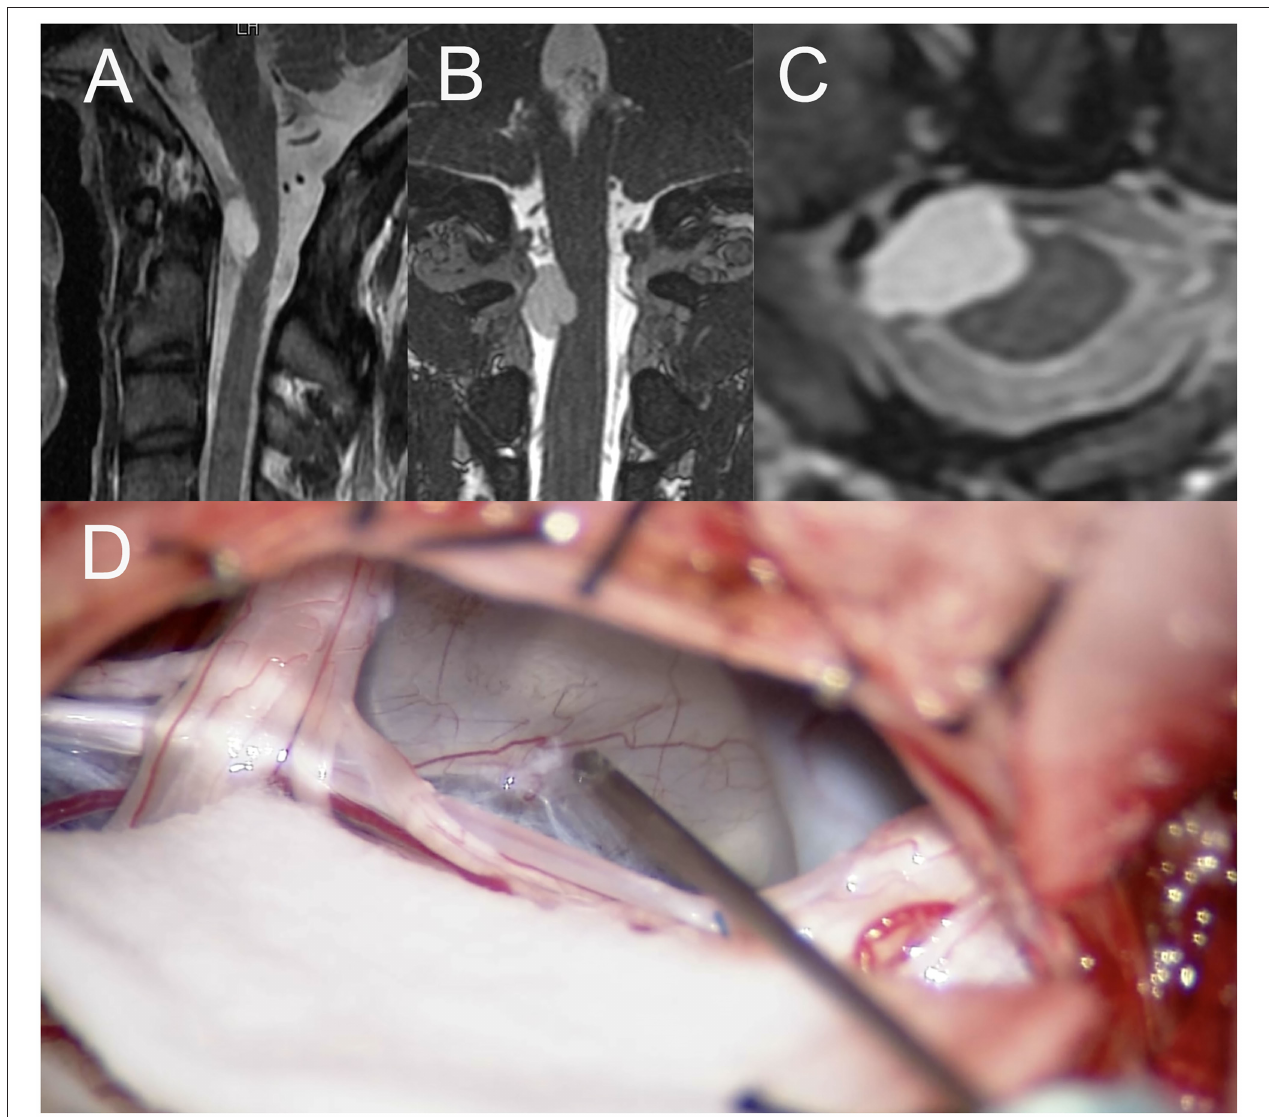
FIGURE 3 | (A) Sagittal image of preoperative T1WI of MRI, (B) the coronal image of preoperative T1WI of MRI, (C) the axial image of preoperative Gd-enhanced T1WI of MRI, (D) intraoperative photograph of tumor resection by posterior approach. TIWI, T1-weighted image; MRI, magnetic resonance imaging; T2WI, T2-weighted image, Gd,